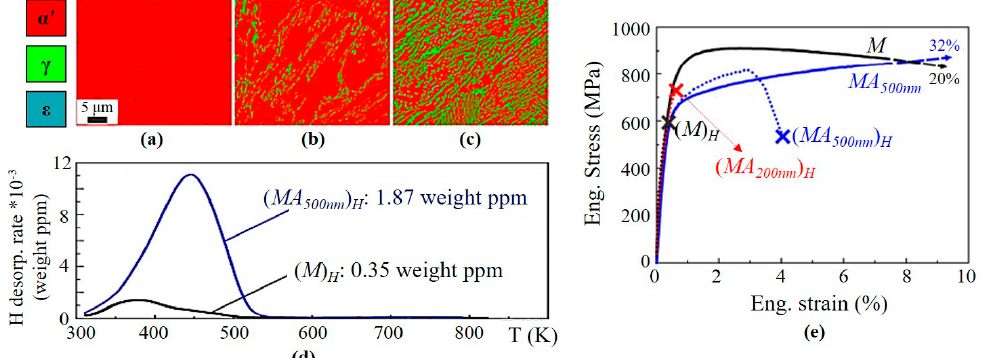
Figure 5. ( a – c ) Electron backscatter diffraction (EBSD) phase map for microstructures of a medium-Mn steel (Fe–0.01C–9Mn– 3Ni–1.4Al, in wt pct). ( a ) As-quenched martensite ( M ). Austenite-reversion-treated microstructures consisting of martensite and austenite films with an average thickness of ( b ) 200 nm ( MA 200nm ) and ( c ) 500 nm ( MA 500nm ). ( d ) H–thermal–desorption analysis results for M and MA 500nm steel samples. ( e ) Engineering stress–strain curves showing SSRT properties. In ( d , e ), corresponding microstructures with H are referred to as ( M ) H , ( MA 200 nm ) H , and ( MA 500nm ) H . Reproduced from Reference [42], with permission from Springer Nature.